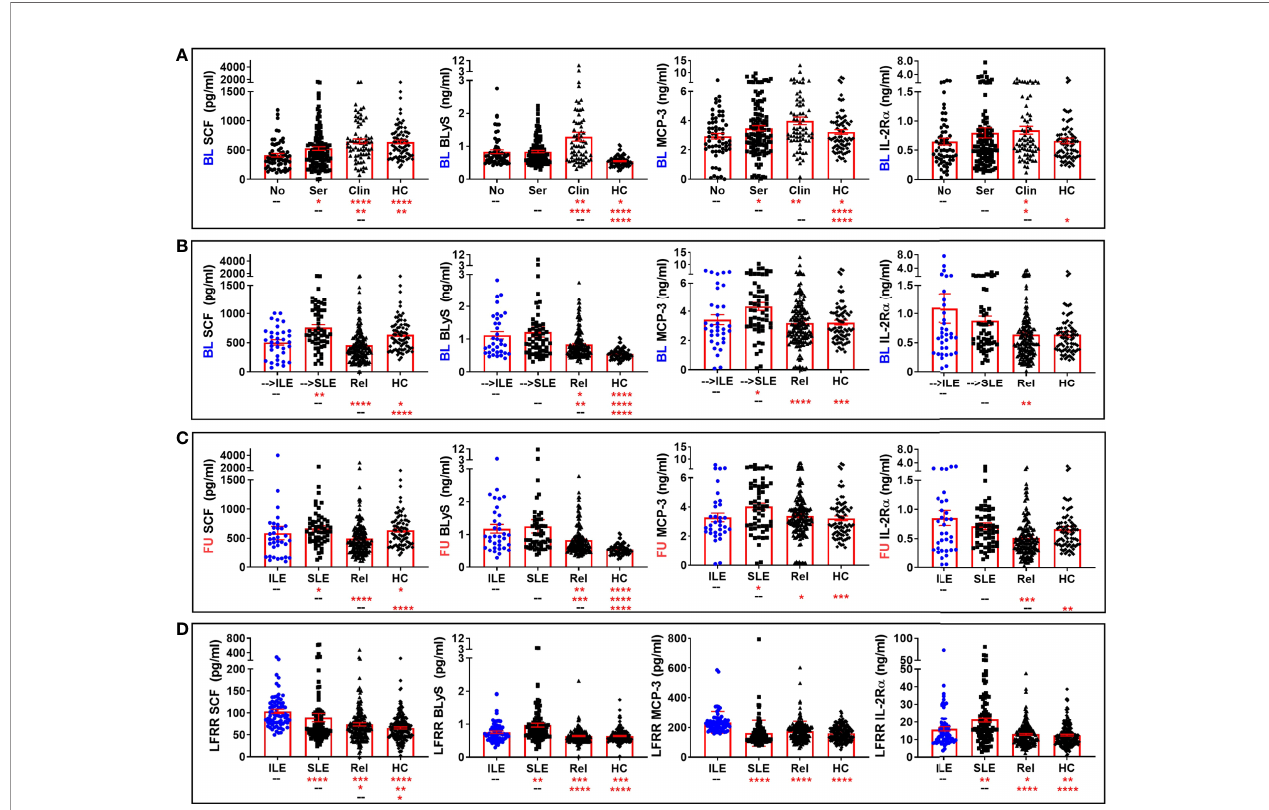
FIGURE 4 | Altered pro-in fl ammatory mediators in lupus relatives who develop ILE or transition to SLE. Lupus relatives and matched healthy controls (HC) were evaluated for plasma levels of stem cell factor (SCF; 1 st column ), BLyS ( 2 nd column ), MCP-3 ( 3 rd column ), and soluble IL-2R a ( 4 th column ) in (A) LAUREL cohort at baseline meeting No ACR criteria (No), only serologic ACR criteria (Ser), or clinical ACR criteria (Clin) vs. matched, unaffected HC and (B-D) lupus relatives who developed ILE (ILE), transitioned to SLE (SLE), or remained clinically unaffected (Rel) vs. matched, unaffected healthy controls (HC) in (B) LAUREL cohort at baseline (pre-transition), (C) LAUREL cohort at follow-up (post-transition), and (D) LFRR con fi rmatory cohort (post-transition). Mean ± SEM. **** p<0.0001 ; *** p<0.001 ; ** p<0.01 ; * p<0.05 by Kruskal-Wallis with Dunn ’ s multiple